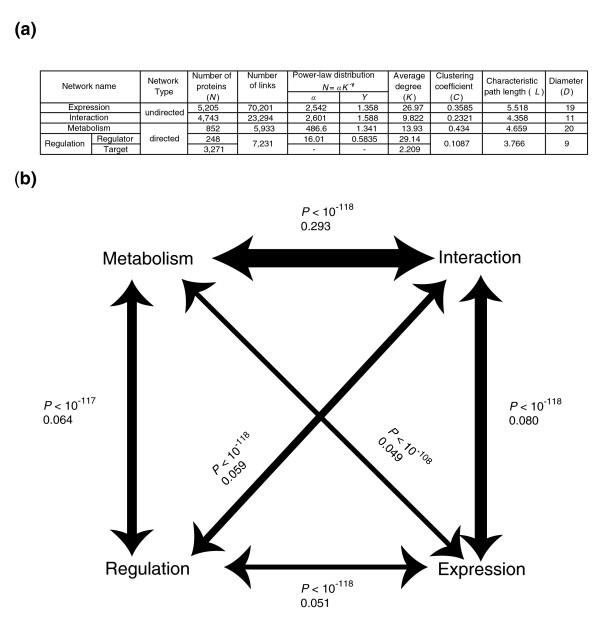
Global comparison of all four networks. (a) Topological statistics of all four networks. Because the degrees in the metabolic network are not divided into outward and inward degrees, we treated the metabolic network as an undirected network when calculating the average degree. (b) Association diagram between all four networks. The association between networks is measured by Cramer's V. The thickness of the line between two networks is proportional to the corresponding V. P values are calculated using standard χ2 tests.